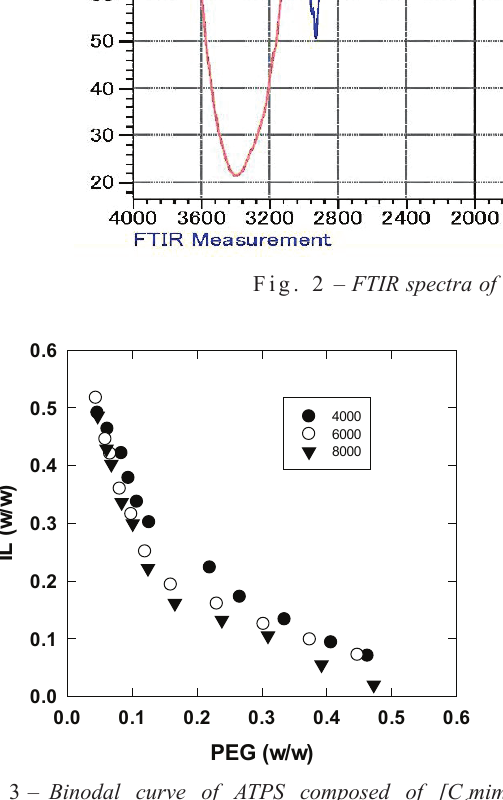
Fig. 2 – FTIR spectra of [C